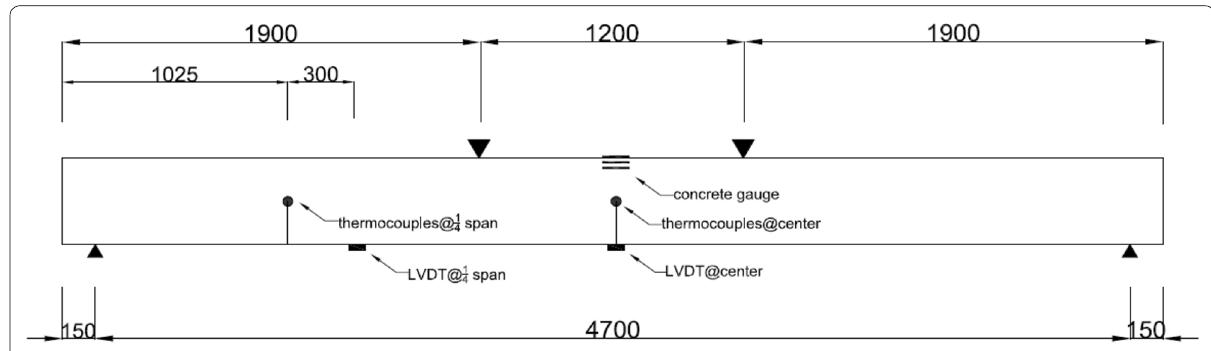
Fig. 3 Set-up and detail of thermocouple and LVDT.